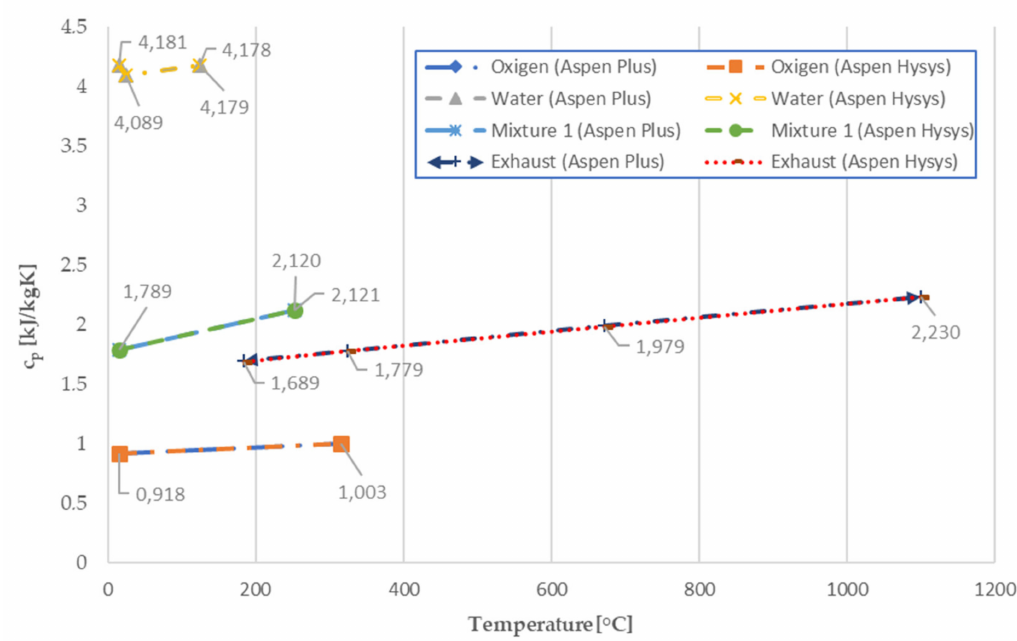
Figure 15. Specific heat capacity (c p ) in nodal points PFD0, mixture 1, WCC exhaust at 10 bar and 1100 ◦ C for Aspen Hysys, Aspen Plus and